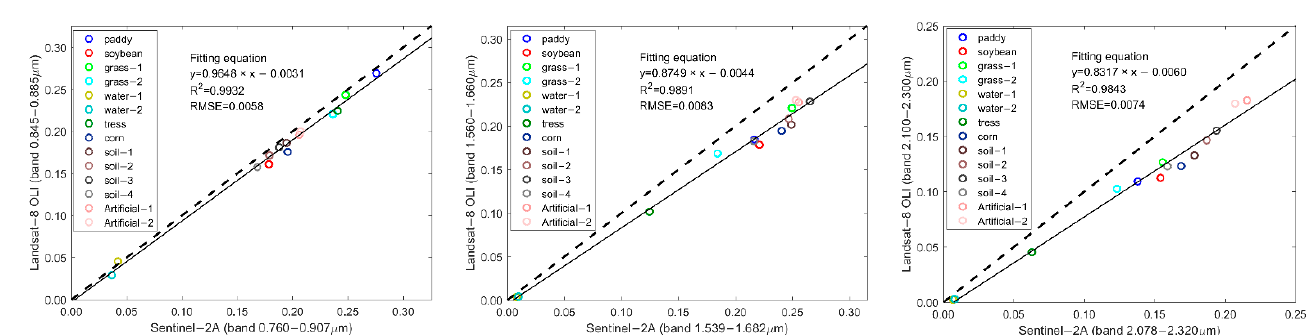
Table 4. Transfer coefficient and error of polygon − multi between Sentinel − 2A and Landsat8 − OLI. Landsat − 8